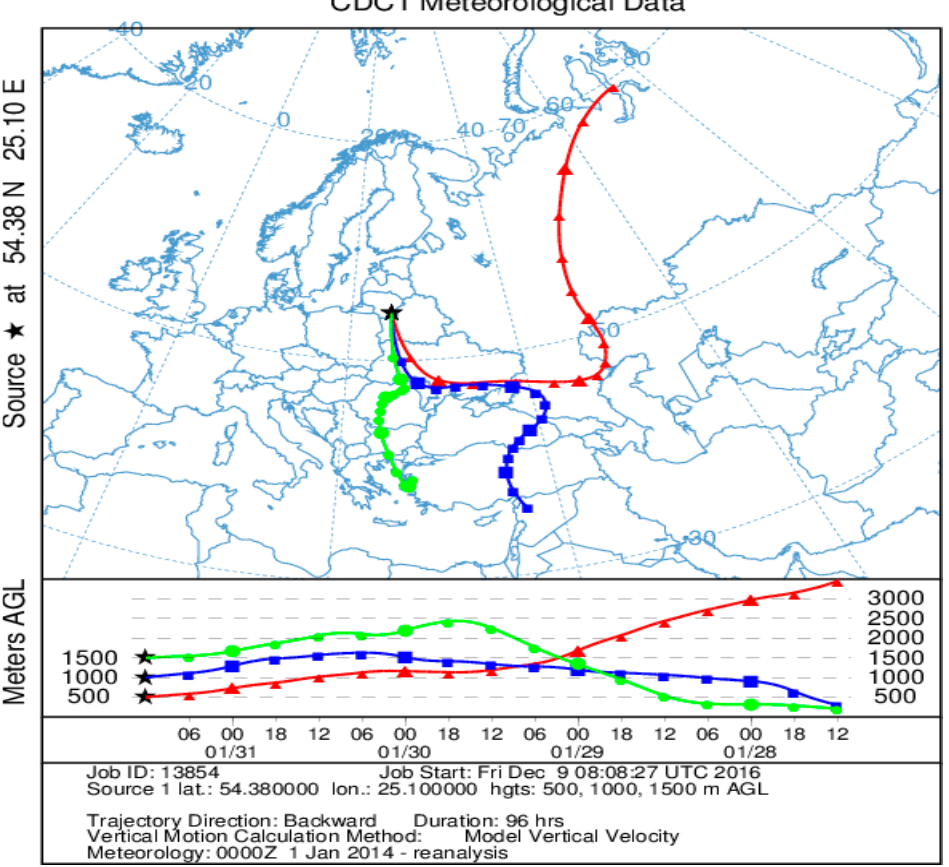
Figure 13. The 96 h backward trajectories of air masses arriving at Vilnius when the pollutant mass concentrations were the lowest. Trajectories were evaluated at each 3 h intervals.